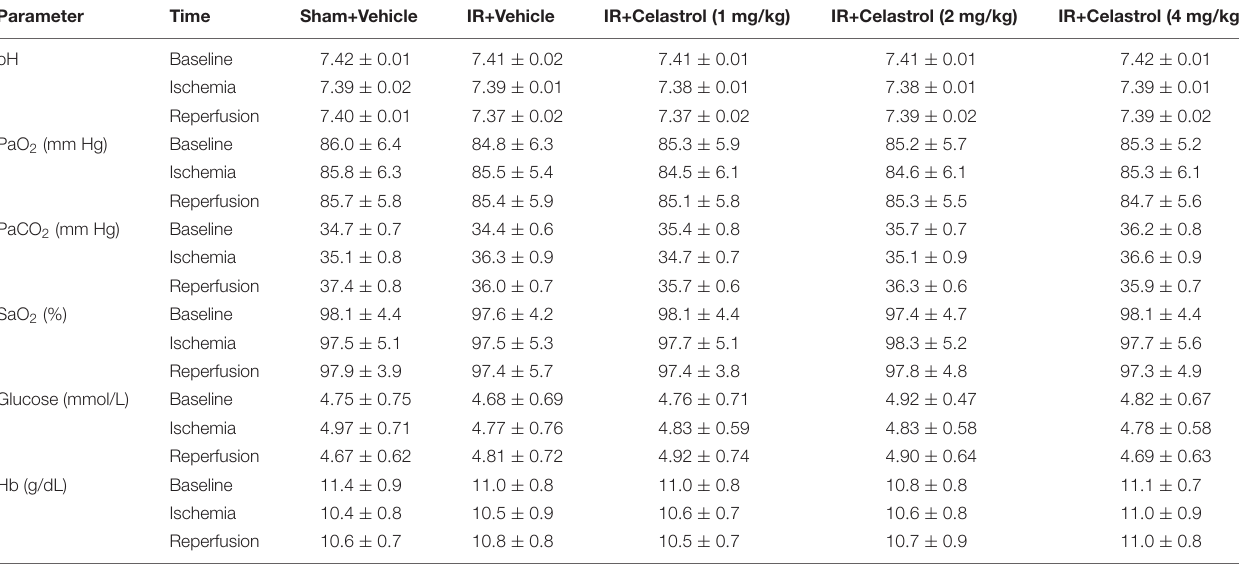
TABLE 1 | Physiological parameters during ischemia/reperfusion period in rats.